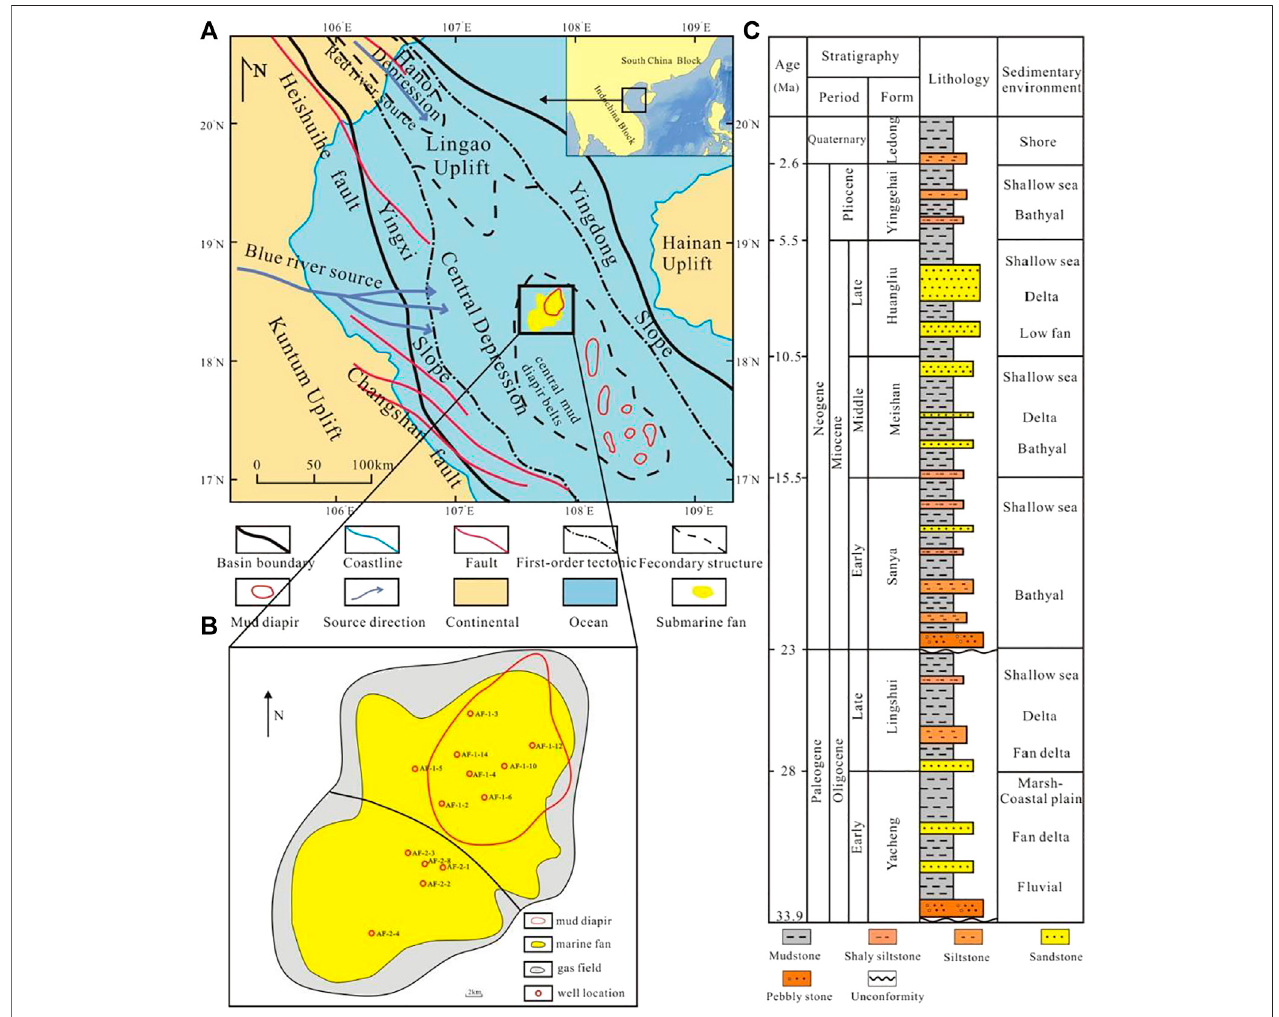
FIGURE1|(A) GeographiclocationoftheYinggehai Basinand thestudy area. (B) Distributionofprospecting wellsinthe Dongfang district. (C) Stratum systemof the Dongfang district. (Panel 1A and Panel 1B are modi fi ed from Huang et al., 2017; Panel 1C is modi fi ed from Duan et al., 2020).